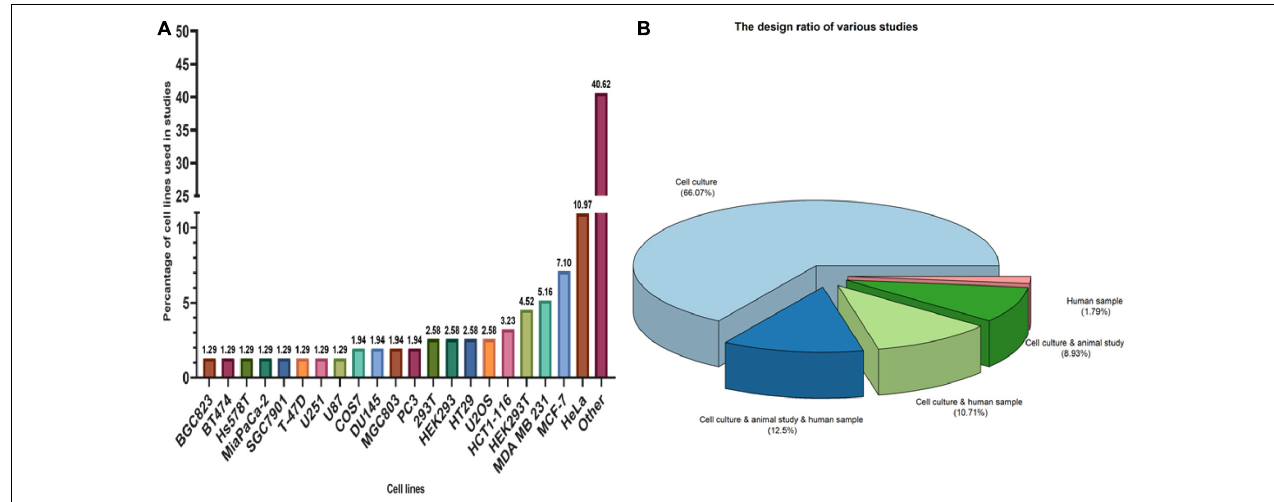
FIGURE 2 | Type of studies and participation of cell lines in studies. (A) The longer the bar, the greater the use of cell lines in studies. The figure shows that Hela cells, MCF-7 and MDA MB 231, respectively, had the highest participation among cell lines. OTHER in this section includes cell lines that have been used only once in studies that include: A341, A498, A549, ACHN, 32D mouse progenitor cells, ALL/MIK, AsPC1, Ba-F3/CL1, BCaP, BC-M1, Bladder carcinoma cell line, BxPc3, CAPAN-1, Capan2, Cos-1, CT2A, DG75, DLD1, F470, HCT-8, Hec50, Hepatocellular carcinoma cells (HCC), HFF-1, HGC-27, HPDE, Hs700T, HT-1080, human B lymphoma cells, human PDAC cell line, Jurkat, K562, KrasG12D HPDE cells, Ku812, LAPC4 cell, LC-M1, LNCaP, MCa-PSTC, MKN45, MNNG, MY, Mycoplasma, N2a, NCI-H508, NCI-H747, NCM460, Panc-1, pancreatic cancer cells, PC-E1, RH-30 cells, S2-013, SNB19, SNUC-1, SW480, T98, TOM-1, U118, U343, uroepithelial cell, VCaP, VMRC-LCD, WEHI-3, yeast, and YMB-1. (B) Among the types of studies, cell culture studies were more frequent, followed by cell culture, animal study, and human samples studies with the highest number with 12.5% in study